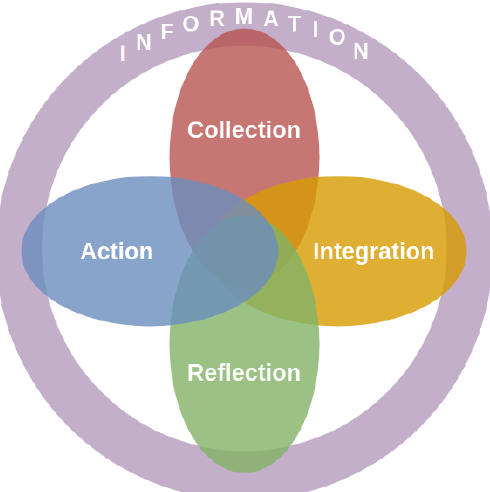
Figure 3. Adapted from Vizer et al.’s conceptual model of shared health informatics (CoMSHI): also based on the stage-based model, the CoMSHI enhances the fluidity of the process by facilitating transitions between stages. It reflects the need for context raised by previous research as